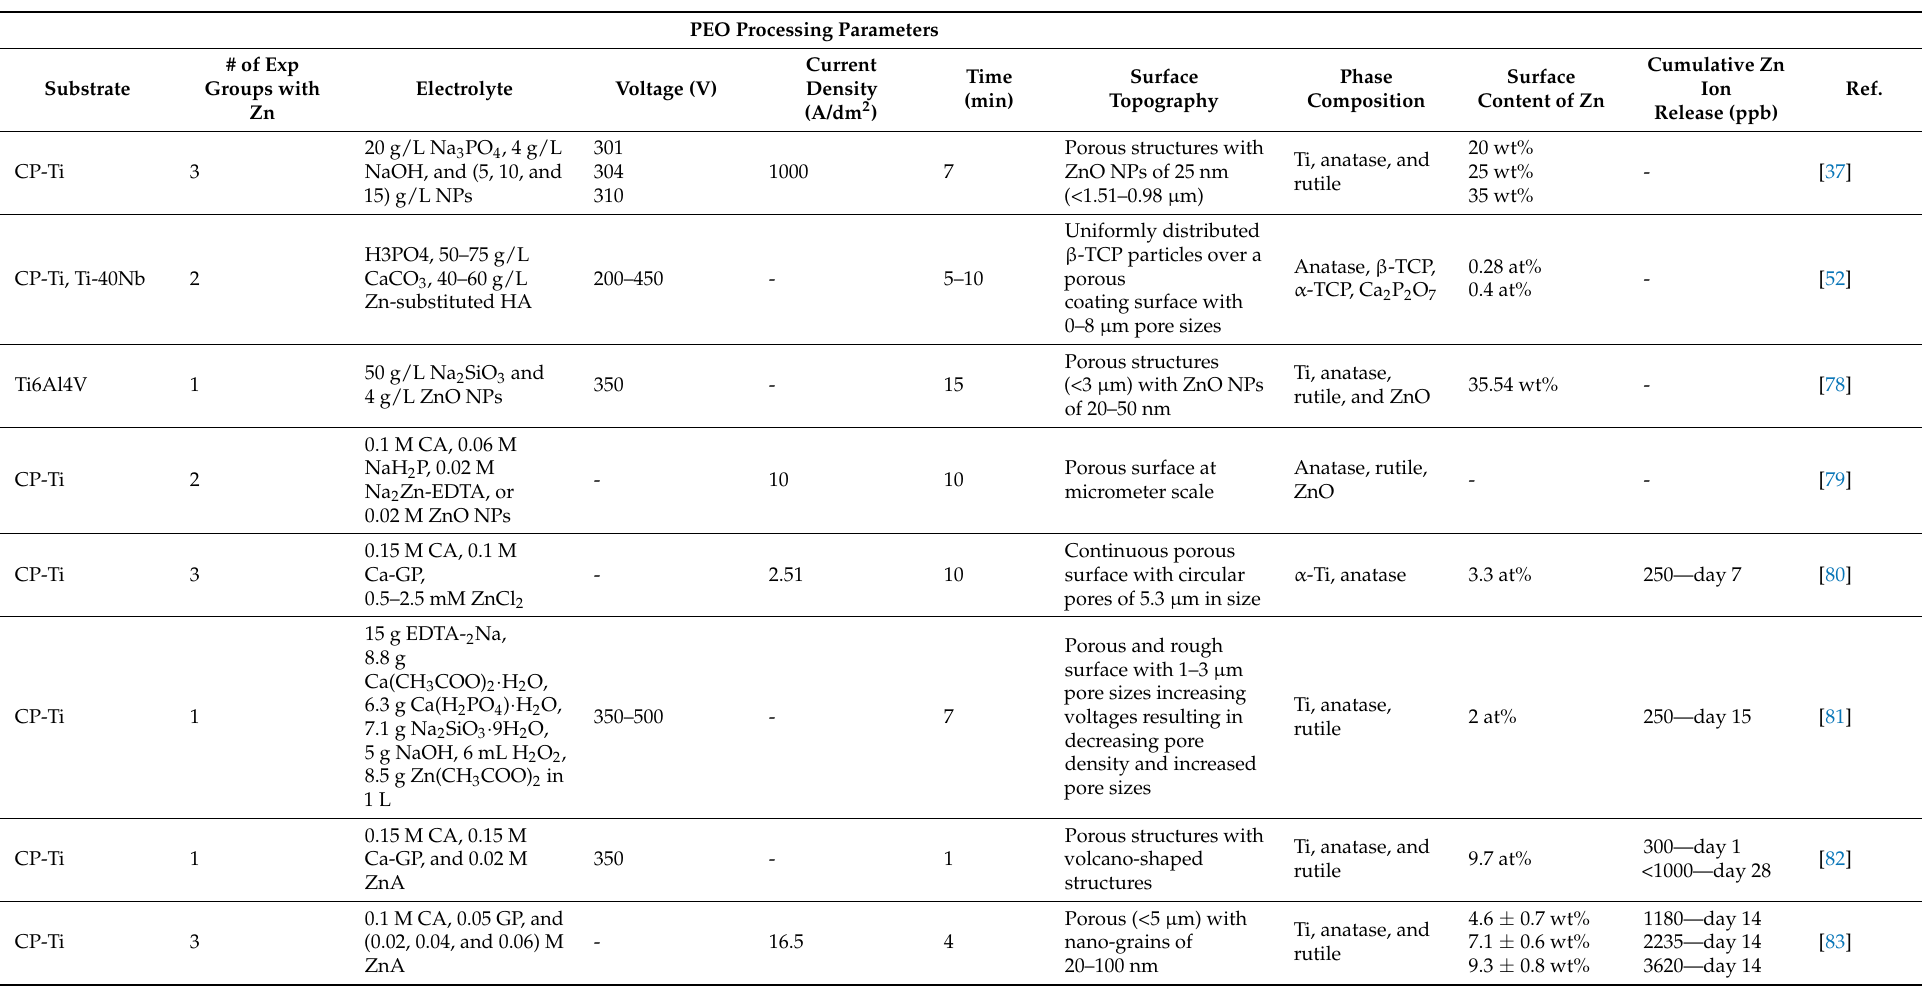
Table 3. The methodological details of the included studies in which Zn was used as the antibacterial agent. PEO Processing